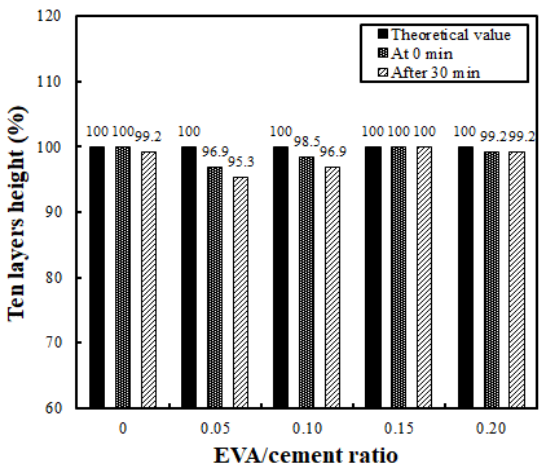
Figure 8. Buildability levels for different EVA/cement ratios and elapsed time.